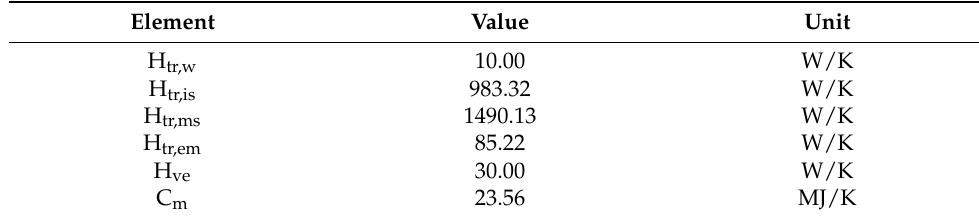
Table 2. Thermal network model elements of the building. Element Value Unit H tr,w 10.00 W/K H tr,is 983.32 W/K H tr,ms 1490.13 W/K H tr,em 85.22 W/K H ve 30.00 W/K C m 23.56